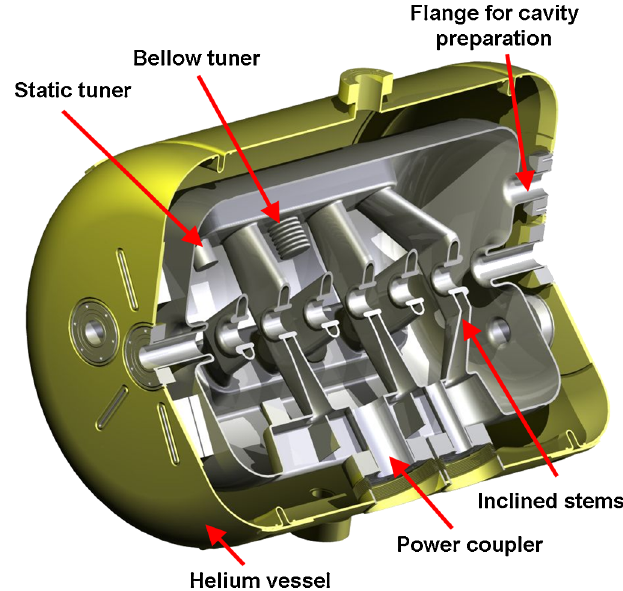
FIG. 3. (Color) Design of the superconducting 325 MHz CH cavity.